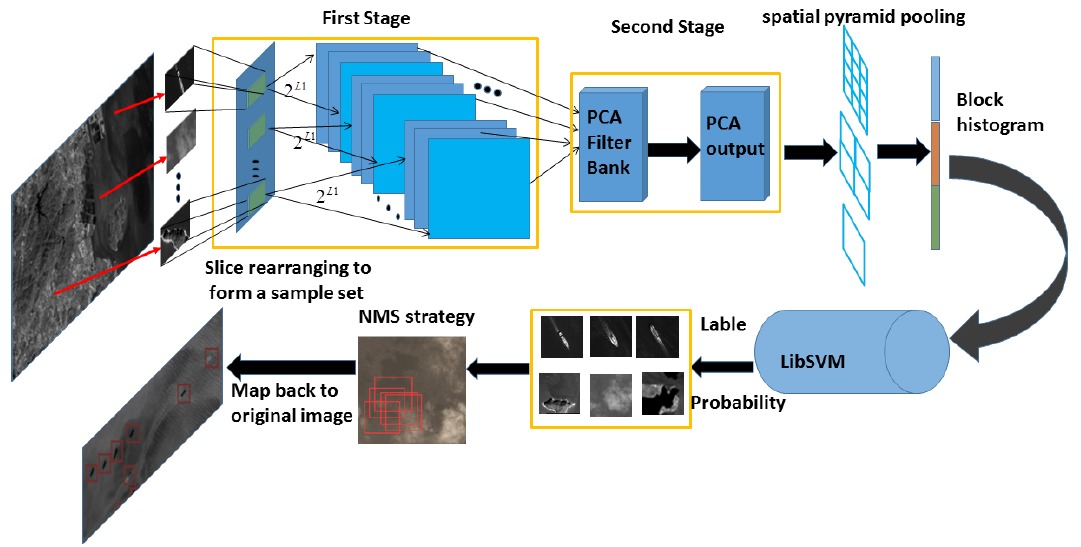
Figure 4. Exclude false alarm diagram. PCANet feature extraction and LibSVM classifier flow